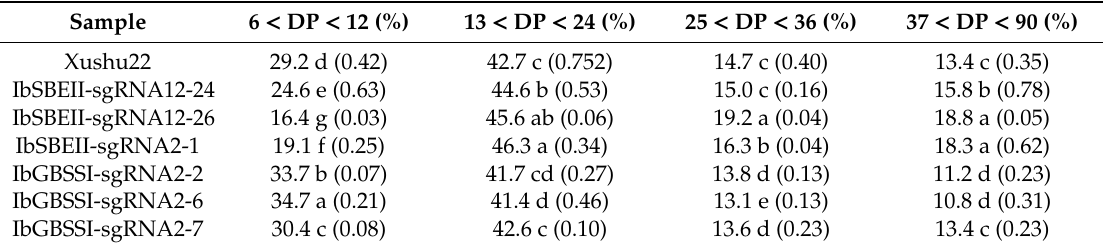
Table 2. Chain length distributions proportion in 90 > DP > 6 of debranched sweet potato starches a,b .